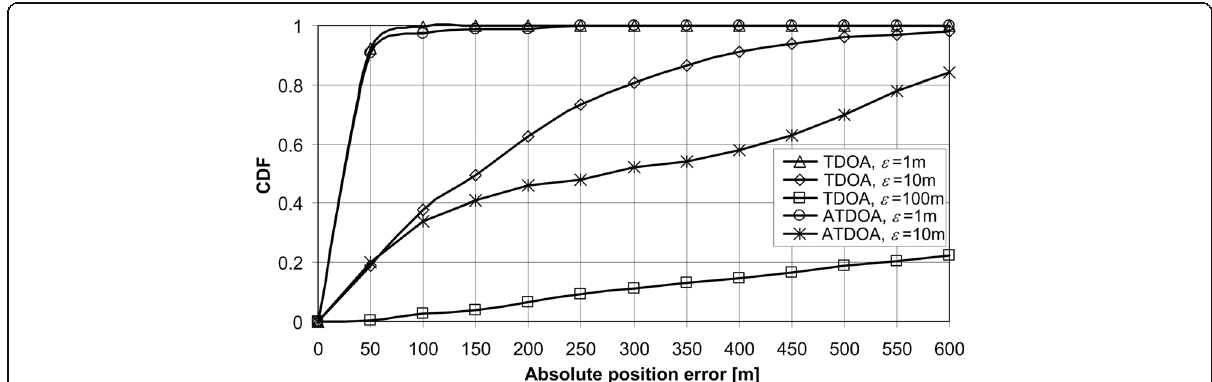
Fig. 5 The CDFs of the absolute position error for the proposed ATDOA method compared with the TDOA method using iterative algorithms TS-LS and IA respectively